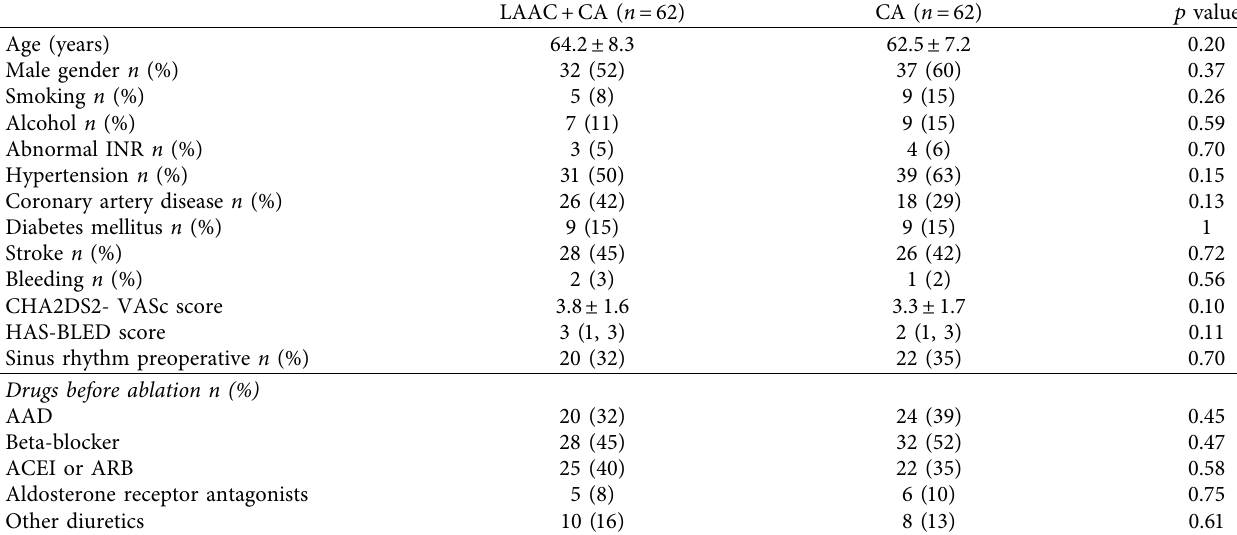
Table 1: Clinical characteristics of the study population at baseline.